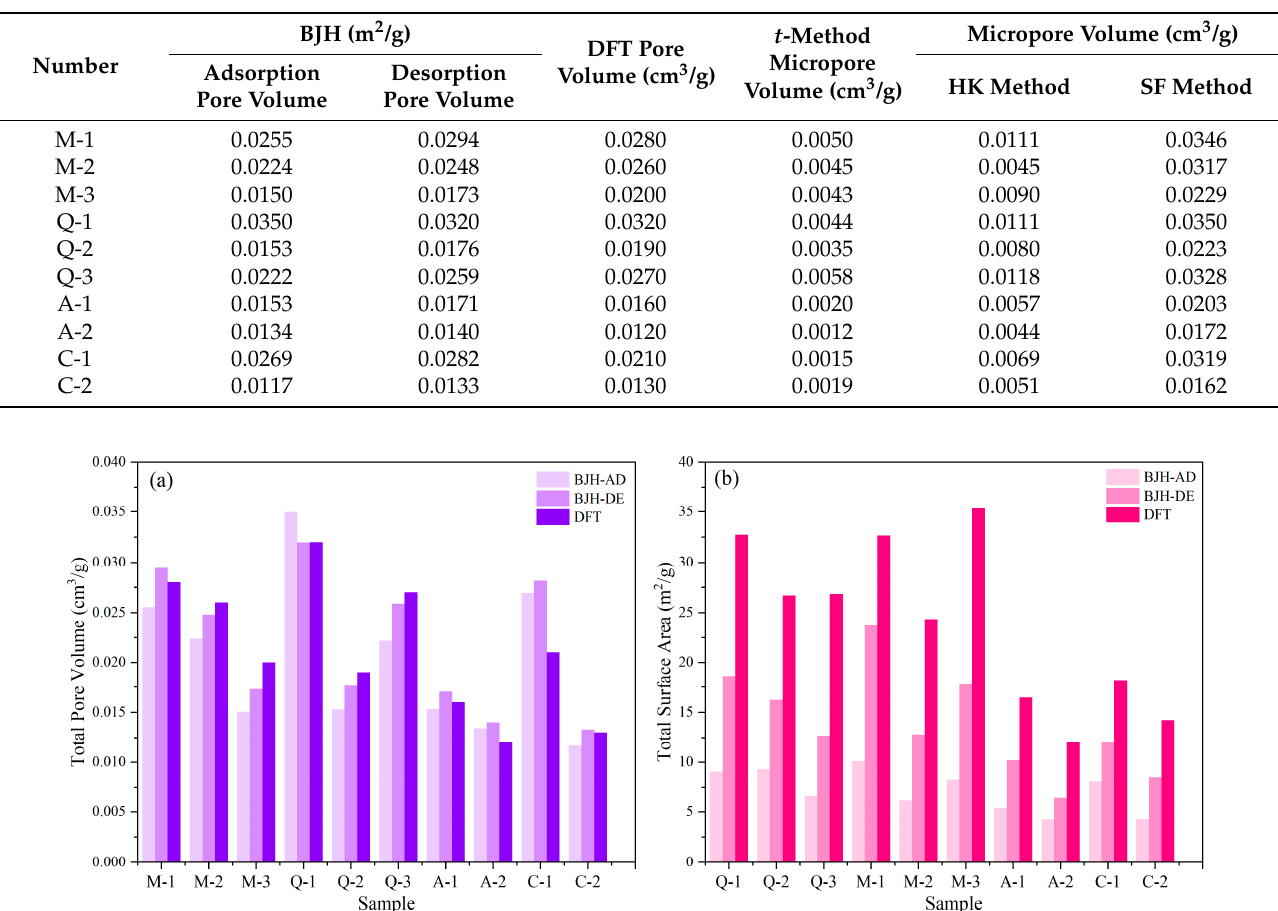
Table 3. Pore volume of the shale samples by the various methods.